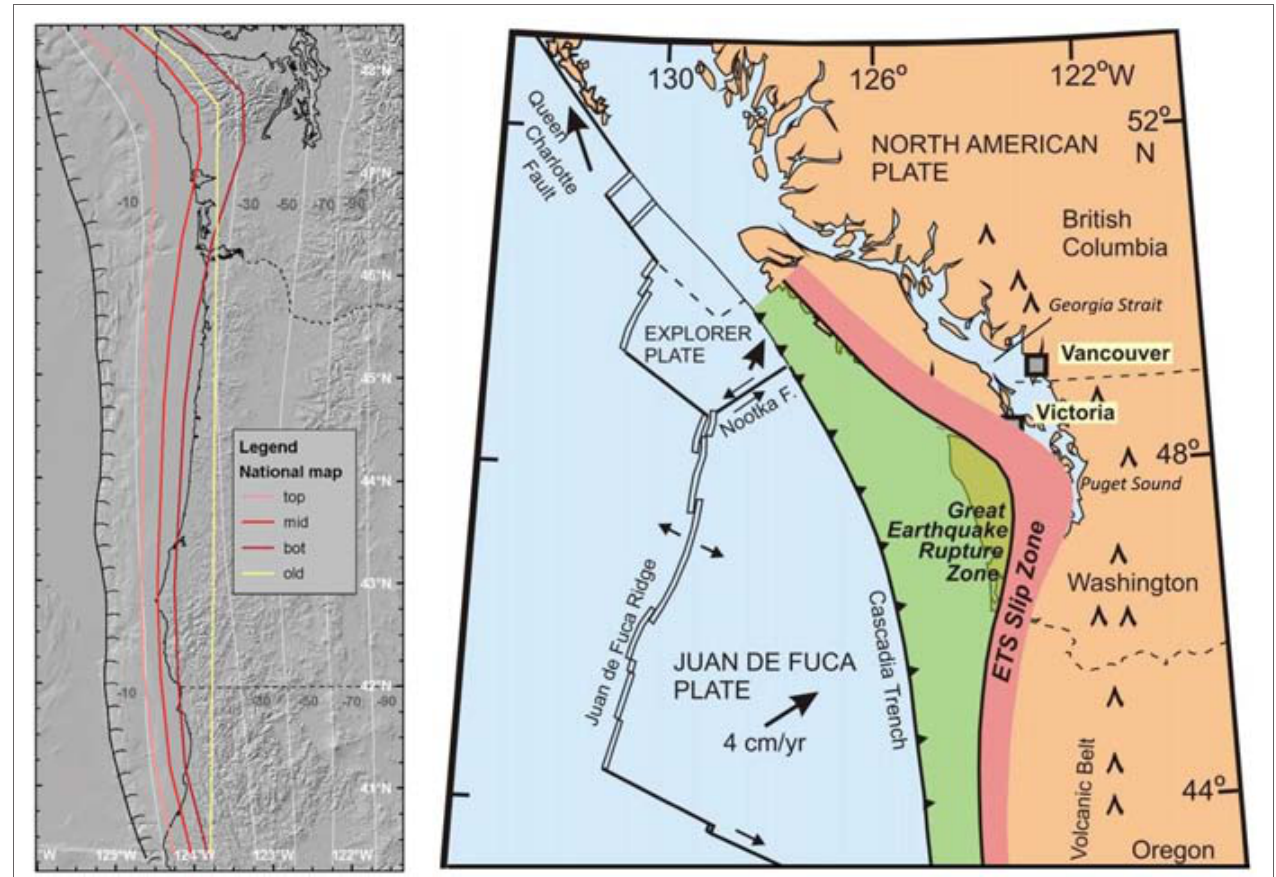
FIGURE 3 | Fault plane geometry of the 2008 USGS model (Frankel and Petersen, 2008a,b) and the 2012–2015 GSC model (Adams et al., 2012; Rogers et al., 2015). (Left) Map of the Cascadia megathrust, showing (as colored lines) the eastern edge of earthquake rupture zones. The light gray lines indicate the subduction interface from McCrory et al. (2004). (Right) Expected rupture zone of great megathrust earthquakes (in green) that is currently stuck and accumulating strain. The pink area is the approximate region of stick-slip behavior called Episodic Tremor and Slip (ETS).